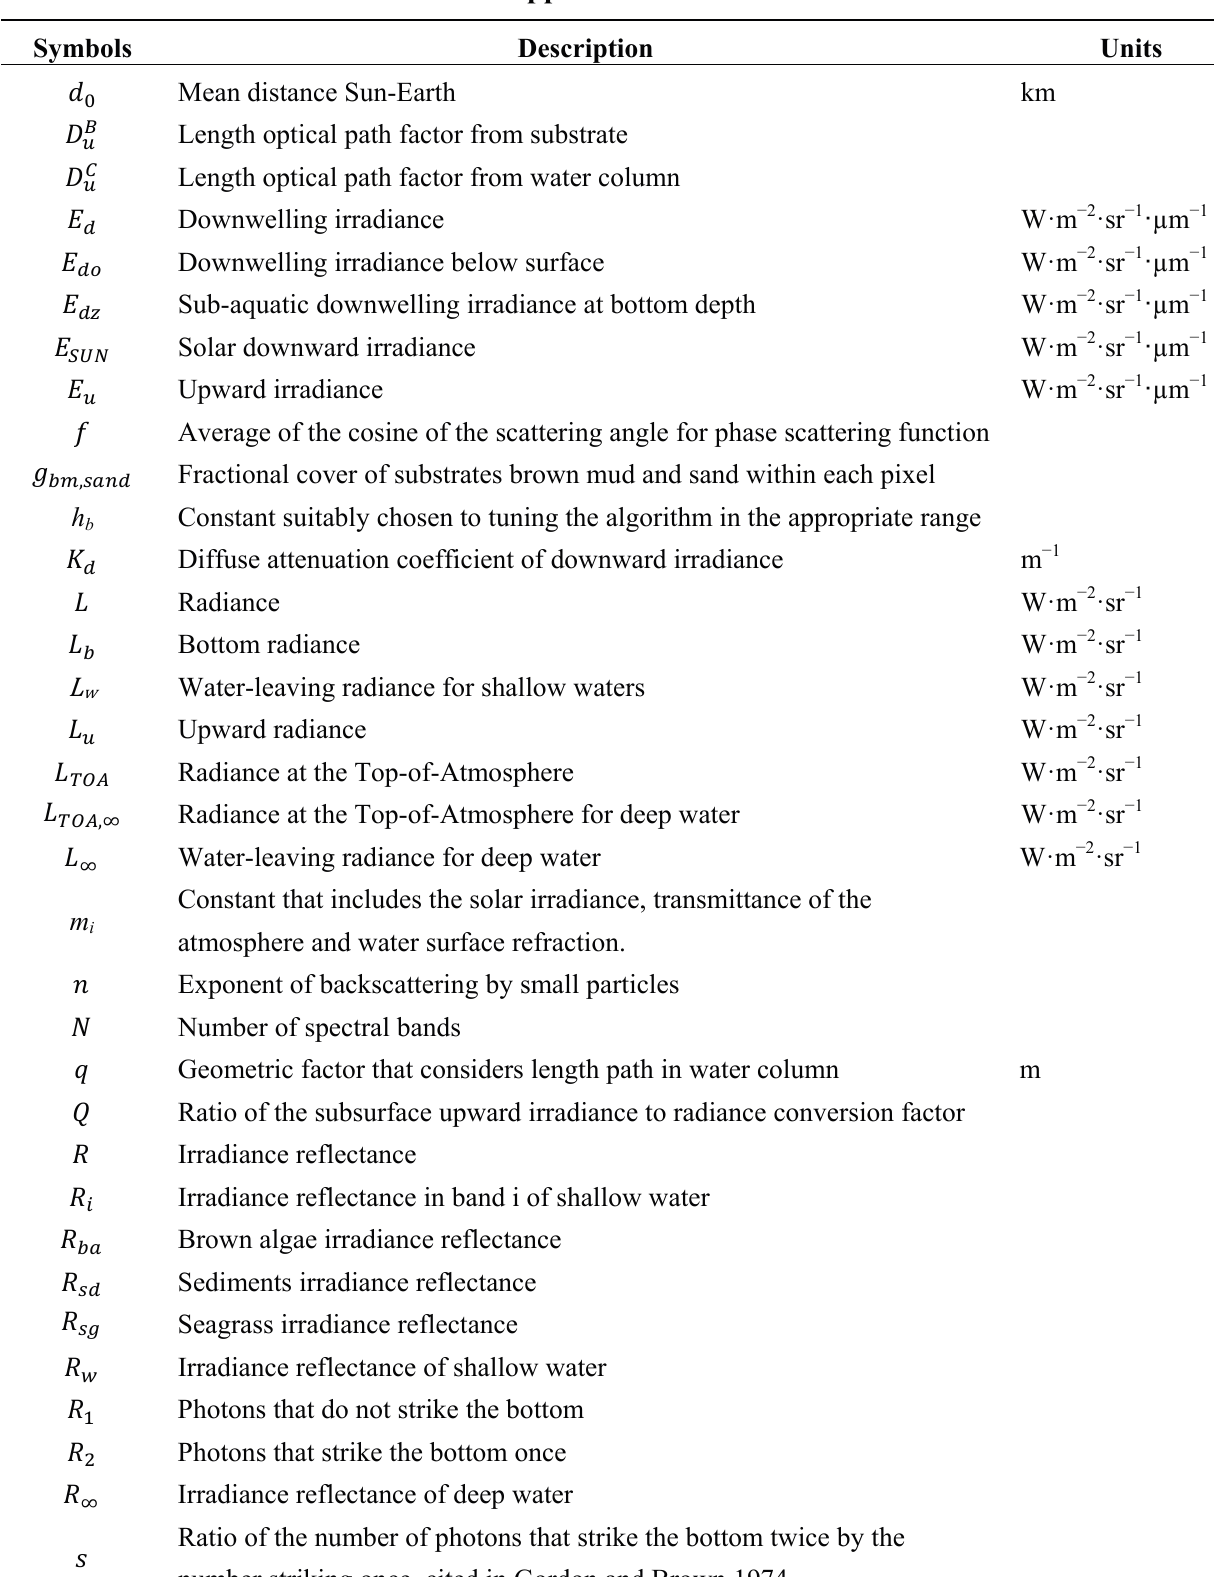
Irradiance reflectance of deep